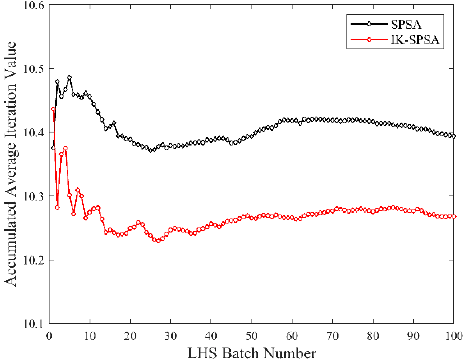
Figure 24. Accumulated average iteration final value distribution at different initial points.